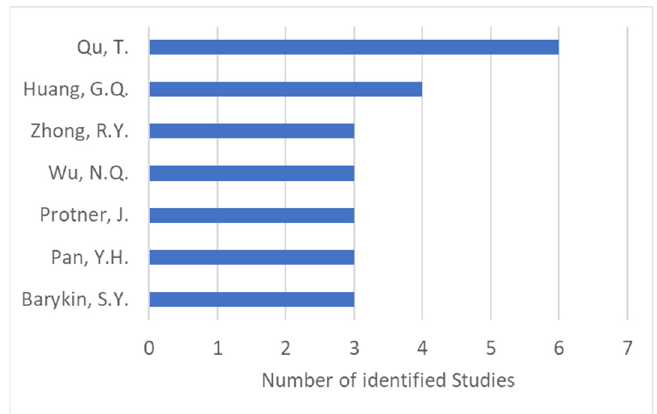
Figure 4. Records by author.